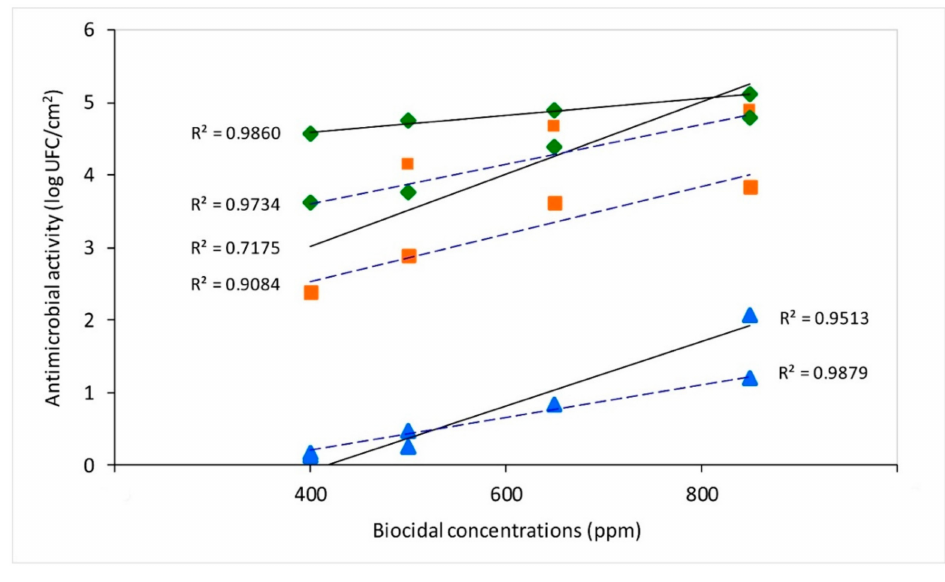
Figure 1. Antimicrobial e ffi cacy against E. coli (———) and S. aureus (– – – –) at di ff erent concentrations on biocidal surface types: Ag–ZnO-NPs, Ag-NPs, and